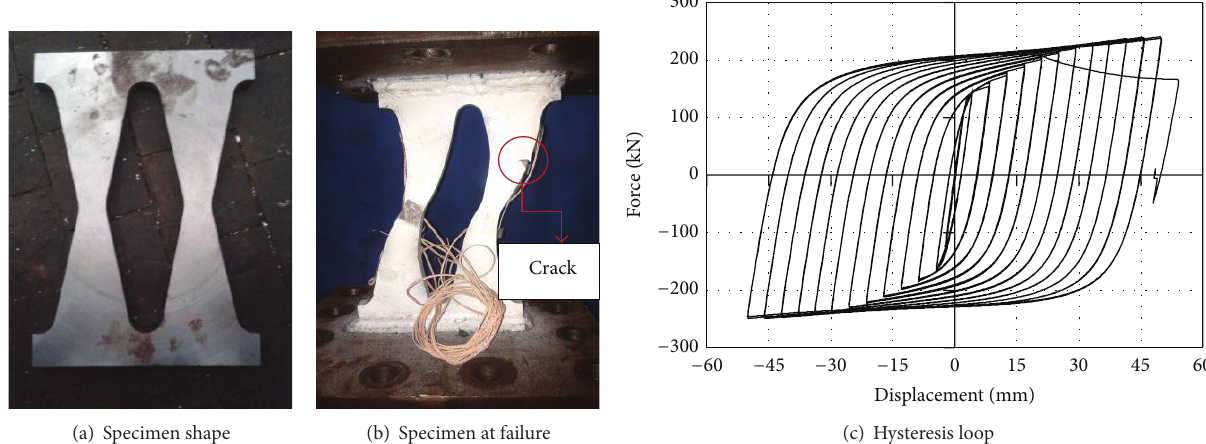
Figure 9: Results of specimen cyclic test for DHSD-1.